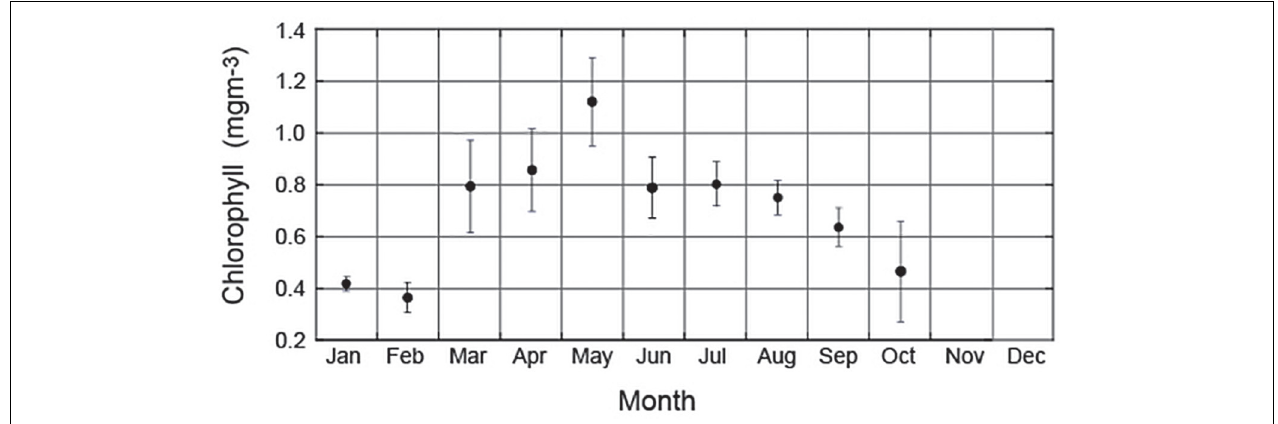
FIGURE 2 | Time series of monthly mean chlorophyll concentration along the Rottnest continental shelf derived using ocean glider data. Vertical bars represent standard deviation. Note that there were insufficient data for November and December.